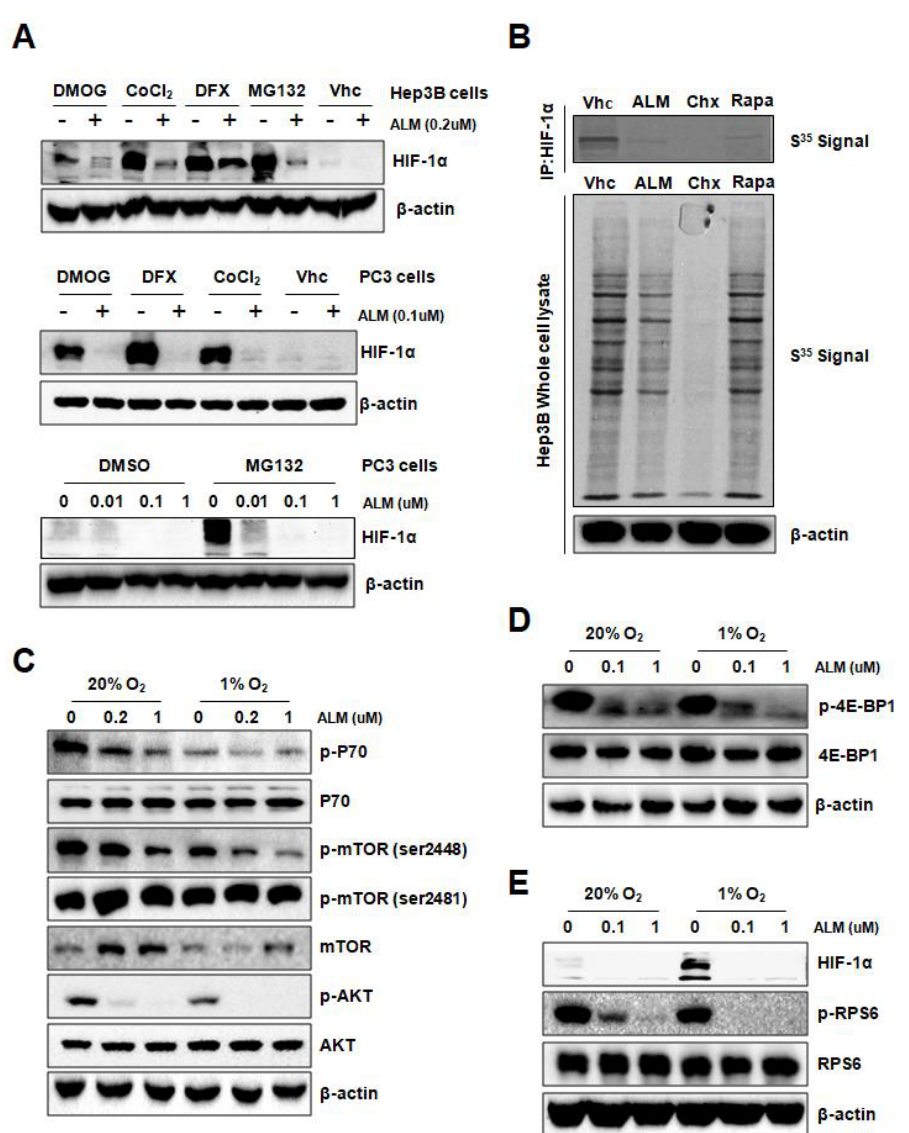
Figure 2. ALM inhibits HIF-1 α translation by down-regulating mTOR pathway. ( A ) Hep3B and PC3 cells were exposed to vehicle or the hypoxia mimics dimethyloxalylglycine (DMOG), cobalt chloride (CoCl 2 ), desferrioxamine (DFX) or MG132 in the presence of ALM at indicated concentrations or vehicle for 24 h and whole cell lysates were subjected to Western blot. ( B ) Hep3B cells were pretreated for 4 h with vehicle (Vhc), 25 nM rapamycin (Rapa), 20 µ g / mL cycloheximide (Chx), or 200 nM ALM, [ 35 S] methionine / cysteine was added for 1 h followed by cell lysis, HIF-1 α immunoprecipitation (IP), SDS / PAGE, and autoradiography. ( C – E ) PC3 cells were cultured at 20% or 1% O 2 for 24 h in the presence of ALM (at the indicated concentrations) and whole cell lysates were subjected to for: ( C ) p-P70, p-Akt, p-mTOR (2448 / 2481), mTOR, ( D ) p-4E-BP1, ( E ) p-RPS6, HIF-1 α , or β -actin.